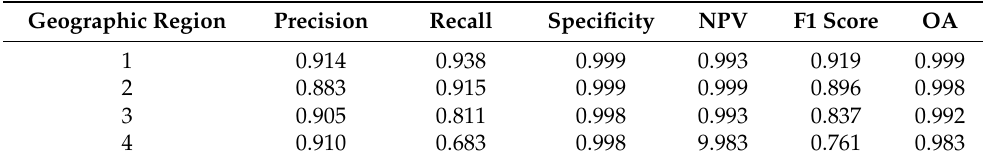
Table 9. Binary classification accuracy assessment from prior study [68] in which mining features were extracted from historic topographic maps. NPV = Negative Predictive